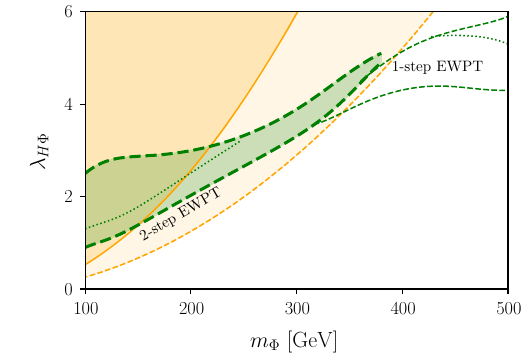
Fig. 5 The region in the plane ( m (cid:2) ,λ h (cid:2) ) where the EWPT is strongly first order is enclosed by the two dashed green lines, each one labeling thestructureofthephasetransition(1-or2-step).Thesub-regionsabove the dotted lines can be tested at LISA. The area enclosed by the solid (dashed) orange line is (could be) excluded at the 95 % CL by current (future) measurements of the Higgs to photon width